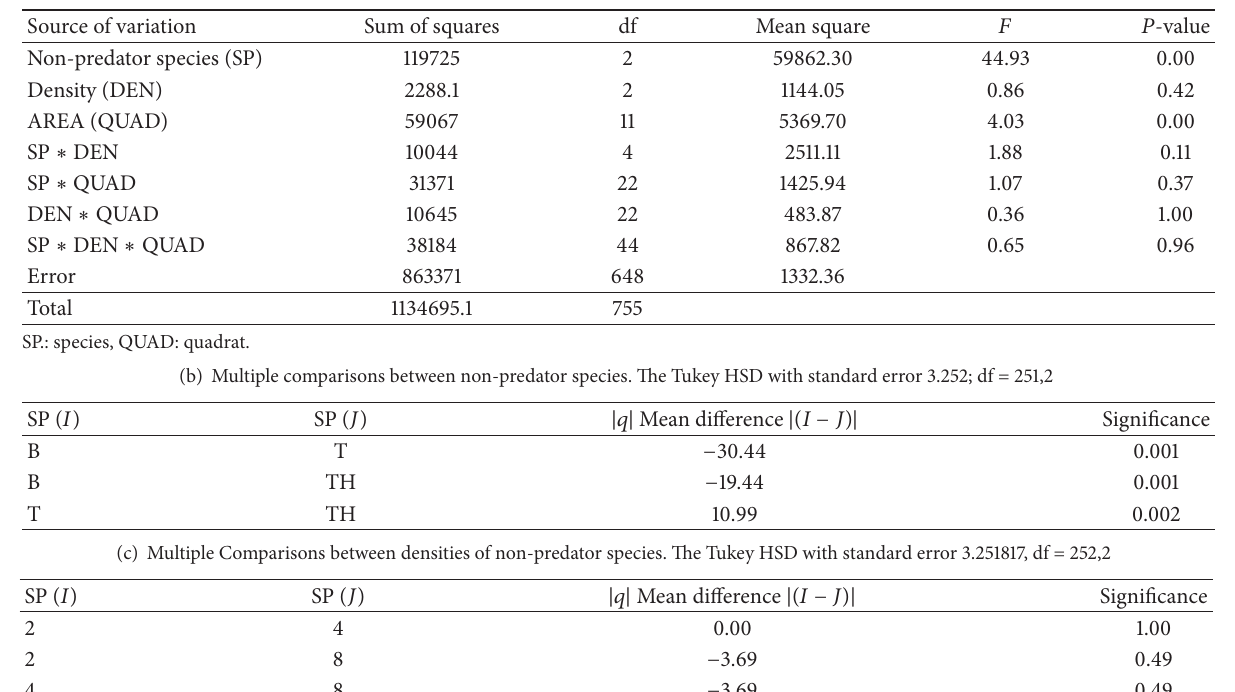
Table 2: The results of 3-way factorial ANOVA on the effects of non-predators on the tube length per quadrat ( 10 ∗ 10.7 cm 2 ) when the non-predators were present as separately as individual species. (a) Source of variation Sum of squares df Mean square 𝐹 𝑃 -value Non-predator species (SP)